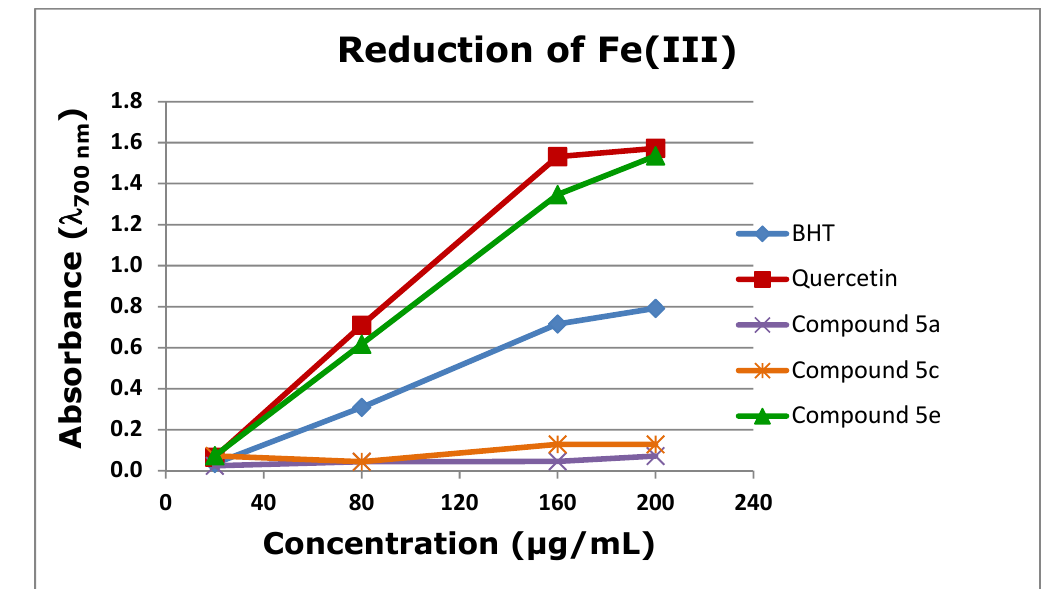
Figure 3. Reducing activity of xanthenediones 5c , e